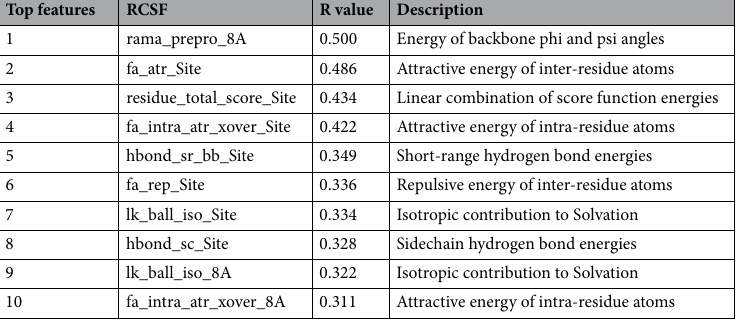
Table 1. The most correlative Rosetta energy features with Uaa mutant soluble fraction. The suffixes of _Site and _8A correspond to energies at the mutation site and the 8A contacting sphere